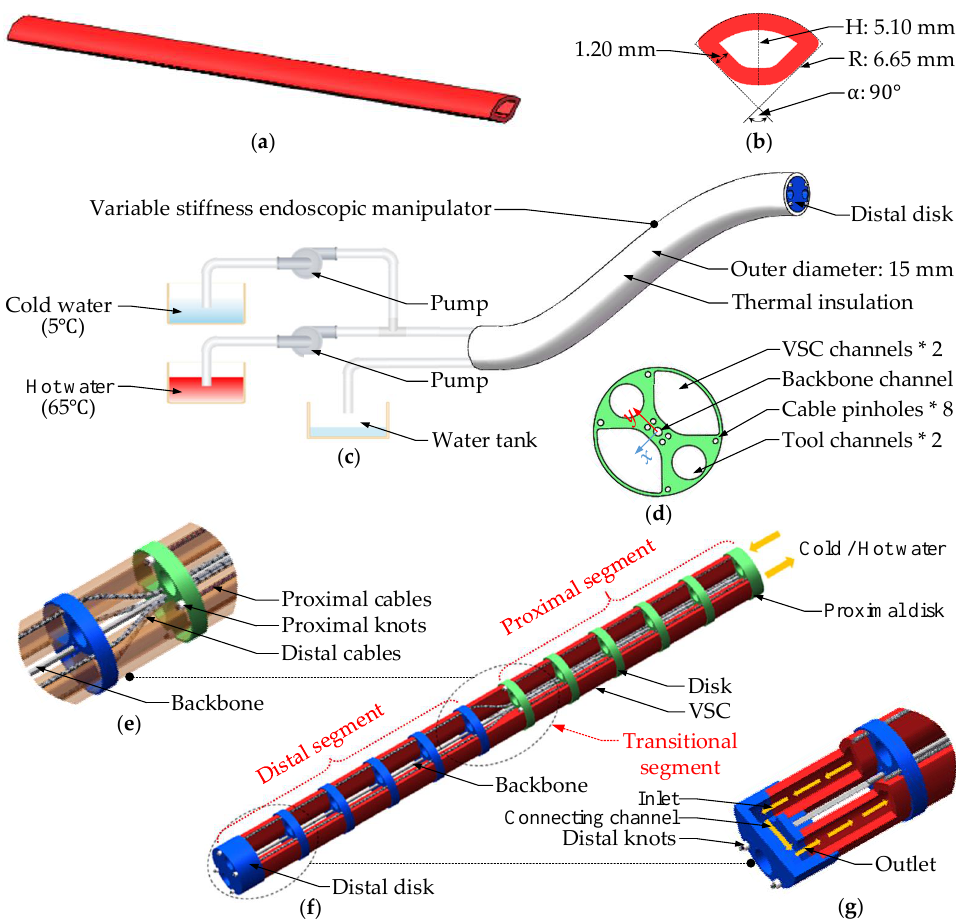
Figure 2. Variable stiffness endoscopic manipulator: ( a ) structure of the VSC; ( b ) VSC’s fan-shaped cross section; ( c ) working principle and external structure of the endoscopic manipulator; ( d ) disk with thickness of 2 mm and OD of 12.2 mm; ( e ) transitional segment between proximal segment and distal segment; ( f ) continuum stiffness-adjusting mechanism with 2 tool channels of 3.75 mm in diameter; ( g ) connecting channel of these two